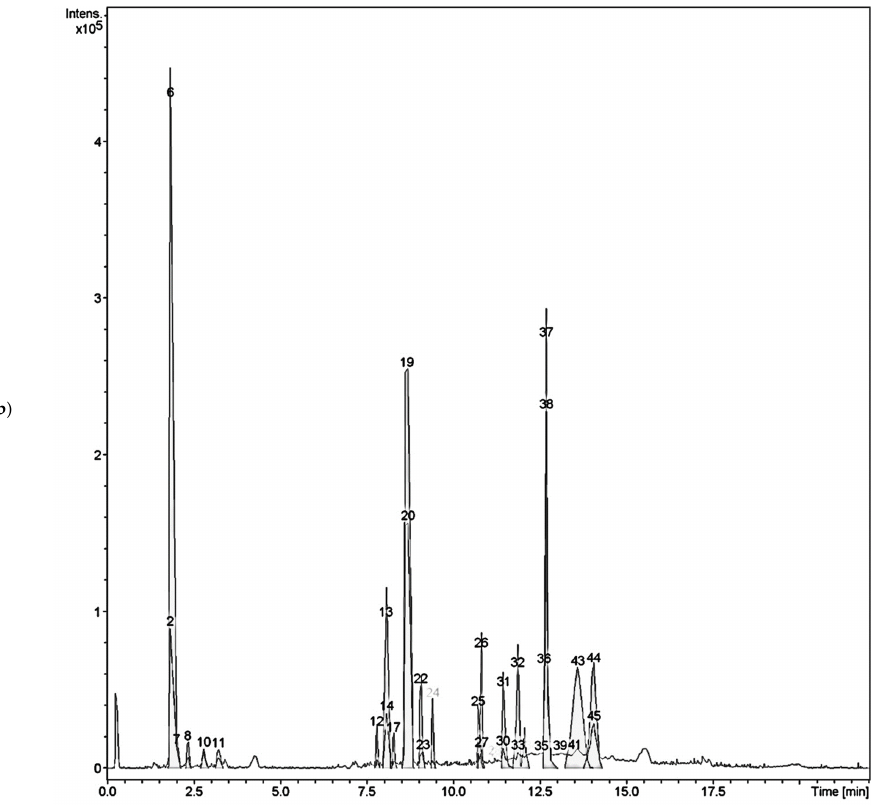
Figure 1. LC ‐ MS/MS chromatograms of the aqueous ethanolic extracts of ( a ) Cassia timoriensis , ( b ) Cassia grandis . The identification of the chemical constituents of each plant was carried out using the available servers and websites (Massbank (https://massbank.eu/MassBank/, accessed on 15 December 2021), MetFrag (https://msbi.ipb ‐ halle.de/MetFrag/, accessed on 20 Decem ‐ ber 2021) , Metline(https://metlin.scripps.edu/, accessed on 1 November 2021) , MoNA (https://mona.fiehnlab.ucdavis.edu/, accessed on 1 January 2022), and CFM ‐ ID(https://cfmid.wishartlab.com/, accessed on 1 November 2021), along with literature data comparison [31,32]. A total of 24 components were found and tentatively identified from C. timoriensis , with the majority of them belonging to the phenolic acid and flavonoid classes. Retention times (Rts), exact molecular weights, molecular formulas, and the main fragment ions of each identified peak are summarized in Table 2. The metabolites that eluted in the first two minutes of the analysis were mainly saccharide moieties such as lactose, D ‐ glucose, and D ‐ mannose. Quinic acid (phenolic acid) was also found at a reten ‐ tion time of 2.3 min and m/z 191.0567. Chemicals detected between 7 and 13 min of anal ‐ ysis time were mainly identified as flavonoids. LC ‐ MS/MS detection and literature data comparison of Cassia species particularly demonstrated the presence of nearly all types of